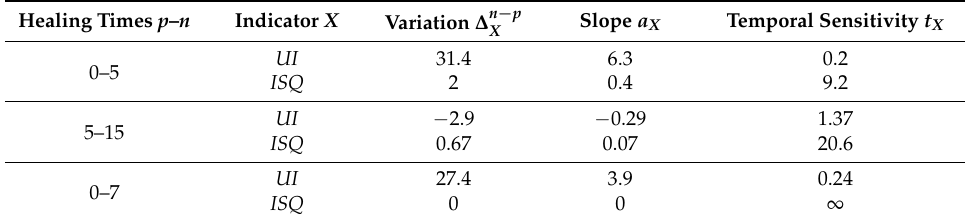
Table 1. Results obtained for implant #2 of the sheep #3. The values of the different indicators that are shown in Figure 6 allow for determining the variations ∆ n indicators for each healing times.